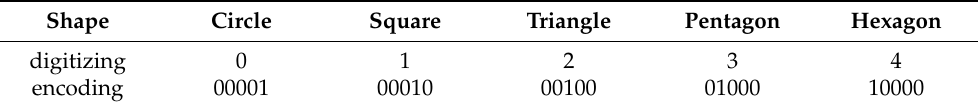
Table 2. The one-hot encoding of the grating shape.